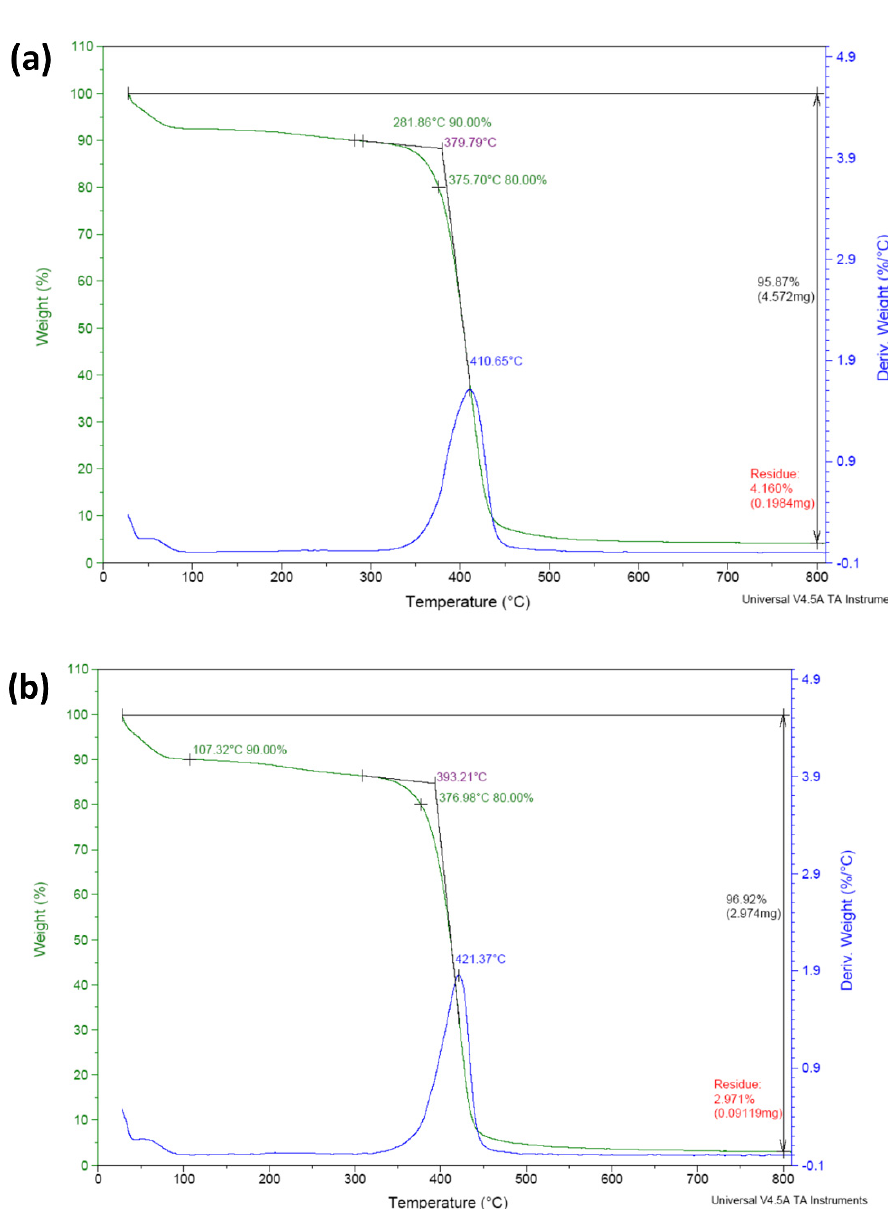
Figure 1. TGA analysis of ( a ) M0.1N5 sample and ( b ) M0.1N5S1 sample.